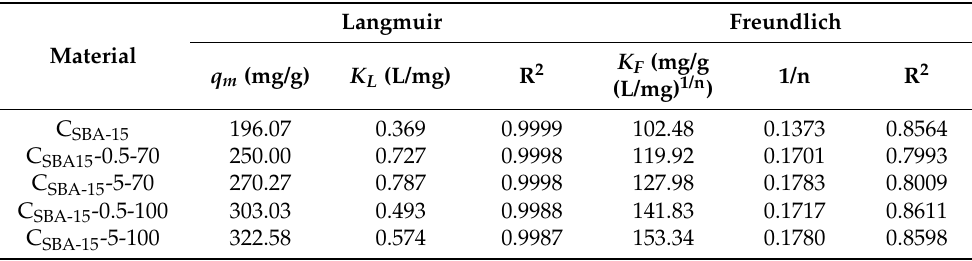
Table 5. The parameters of linear form of Langmuir and Freundlich models for rhodamine B adsorption onto carbon materials.